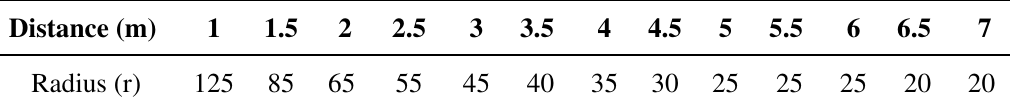
Figure 7. Object size variations measured in a pixel with a rectangular object (20 cm wide) in depth images at different distances from 60 cm to 750 cm. Table 1. Radius (r) of the MLBP used for the evaluation to measure the accuracy of hand detection at different